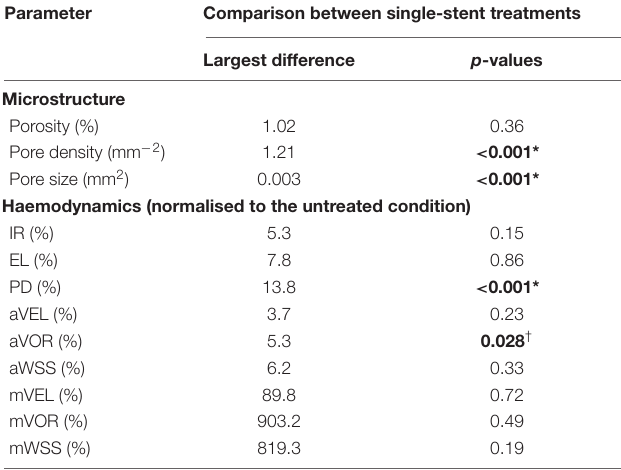
TABLE 2 | Comparisons between single-stent treatments with devices of different diameters (scenarios “F” and “L”) in terms of stent microstructure and aneurysmal haemodynamics ( n = 15).